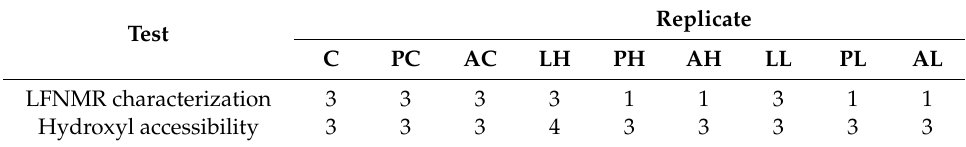
Table 1. Replicates of control wood (C), wood with low hemicelluloses (LH), wood with low lignin (LL), pyridine-treated wood (PC), acetylated wood (AC), acetylated wood with low hemicelluloses (AH), and acetylated wood with low lignin (AL) used for di ff erent tests. LFNMR: low-field nuclear magnetic